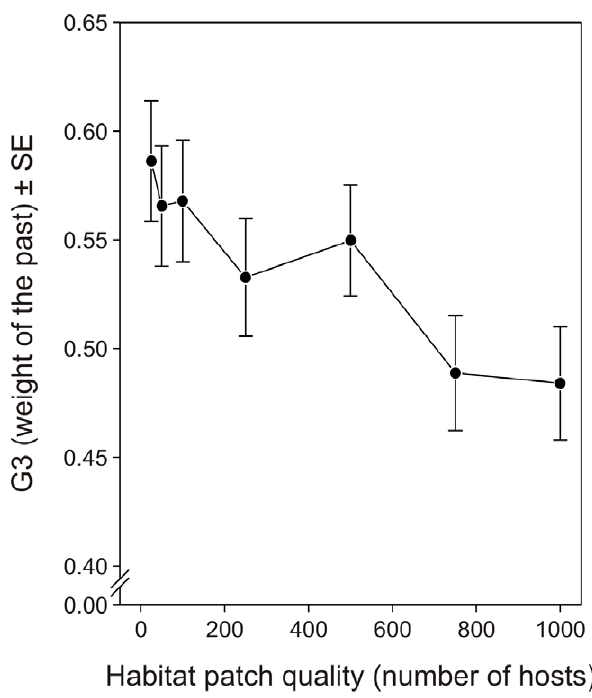
Figure 7. Effect of habitat patch quality on the optimized values of the parameter G3. Average ( 6 SE) optimized values of G3 defining the weight of the past in the learning ability (see Figure 1) of parasitoid females foraging for hosts in environments with different habitat patch qualities.